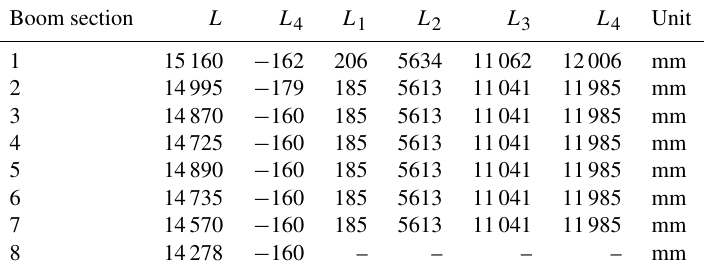
Table 1. Length parameters of boom sections.